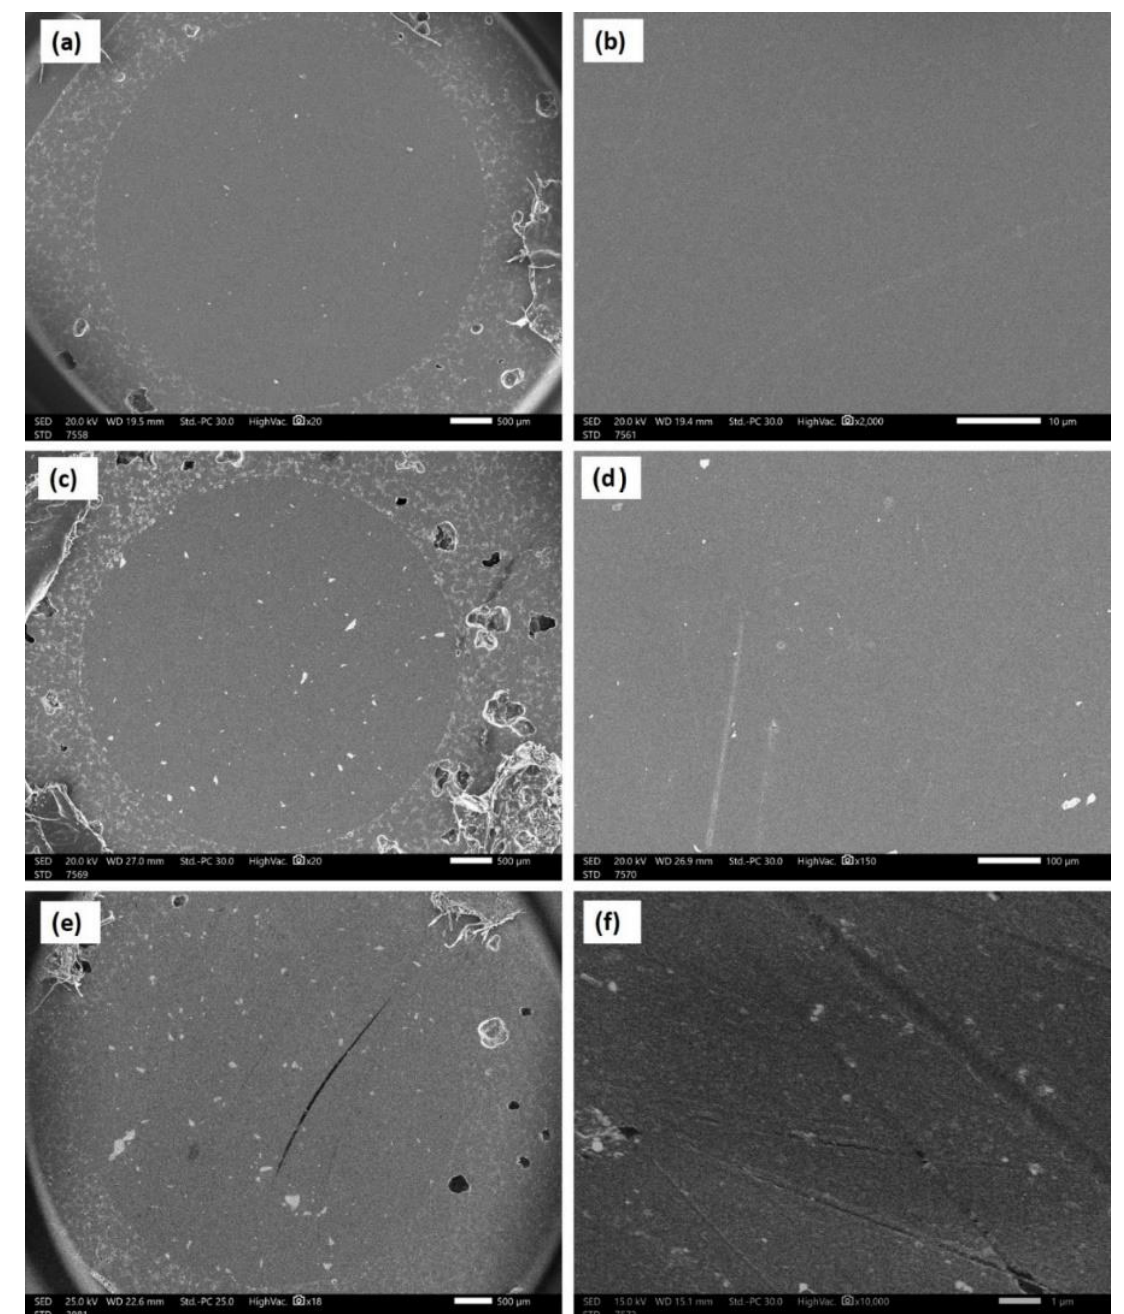
Figure 6. SEM macro and micrographs of the base acrylic material( a , b ), ( c , d ) 5 wt.% ZrO 2 nano- composites ( c , d ) and 10 wt.% ZrO 2 nano-composites ( e , f ).